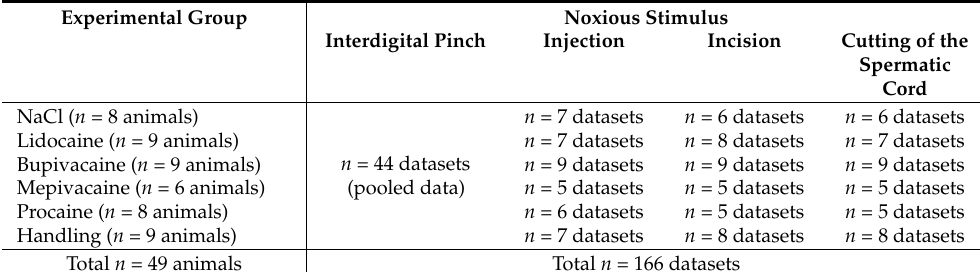
Table 1. Overview: Number of Datasets Used in the EEG Analysis.